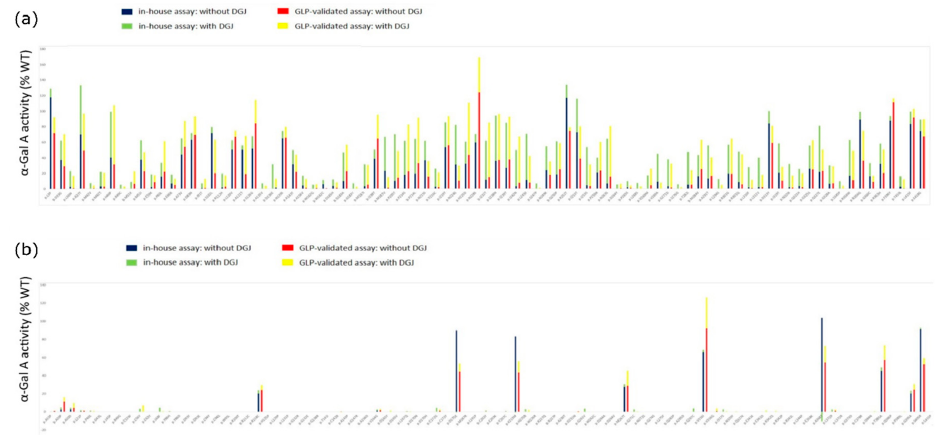
Figure A1. Comparison of α -Gal A activity of GLA gene variants without and with the addition of DGJ between the in-house assay and GLP-validated assay [14]. ( a ) GLA gene variants that were classified as amenable according to in-house data. ( b ) GLA gene variants that were classified as non-amenable according to in-house data. GLA variants were ordered with respect to their positions on the amino-acid sequence. Variants with no associated bar had no quantifiable α -Gal A activity without or with the addition of DGJ.